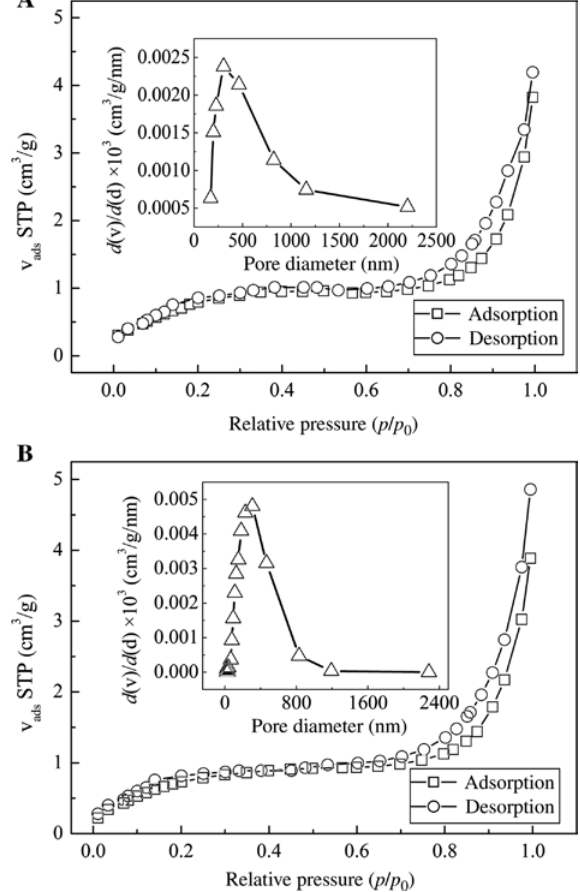
Figure 6: Nitrogen gas physisorption isotherms (−196 ° C) and the corresponding pore size distributions ( insets ) of (A) native SVR and (B) sulfate material synthesized with sulfuric acid. Pore size distri- butions were calculated from the adsorption branch of the isotherm using the NLDFT